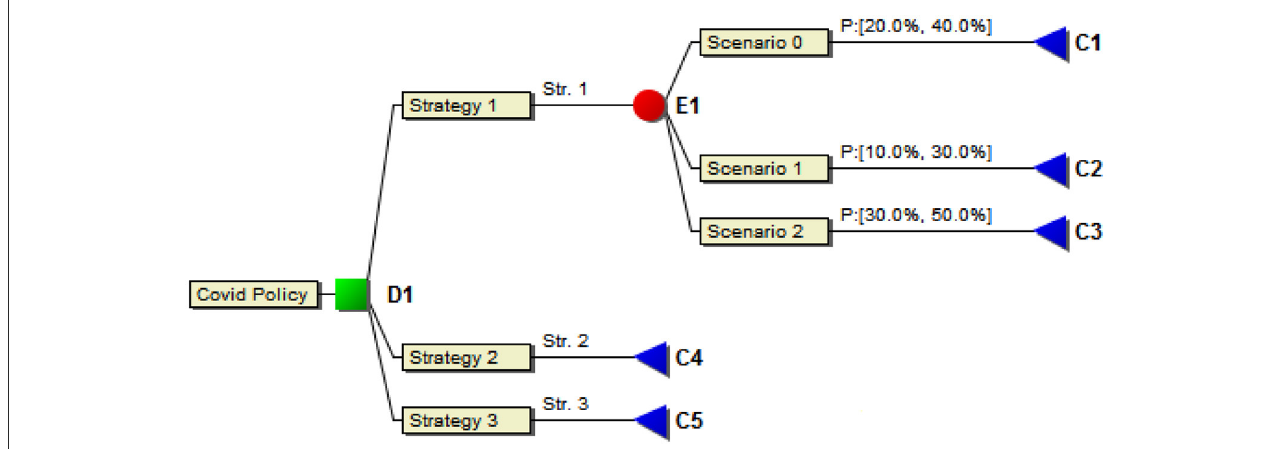
FIGURE5 Strategy model with scenarios. For strategy 1, relying on the current vaccination programme, the three scenarios of Figures 3, 4, and their probability intervals, are